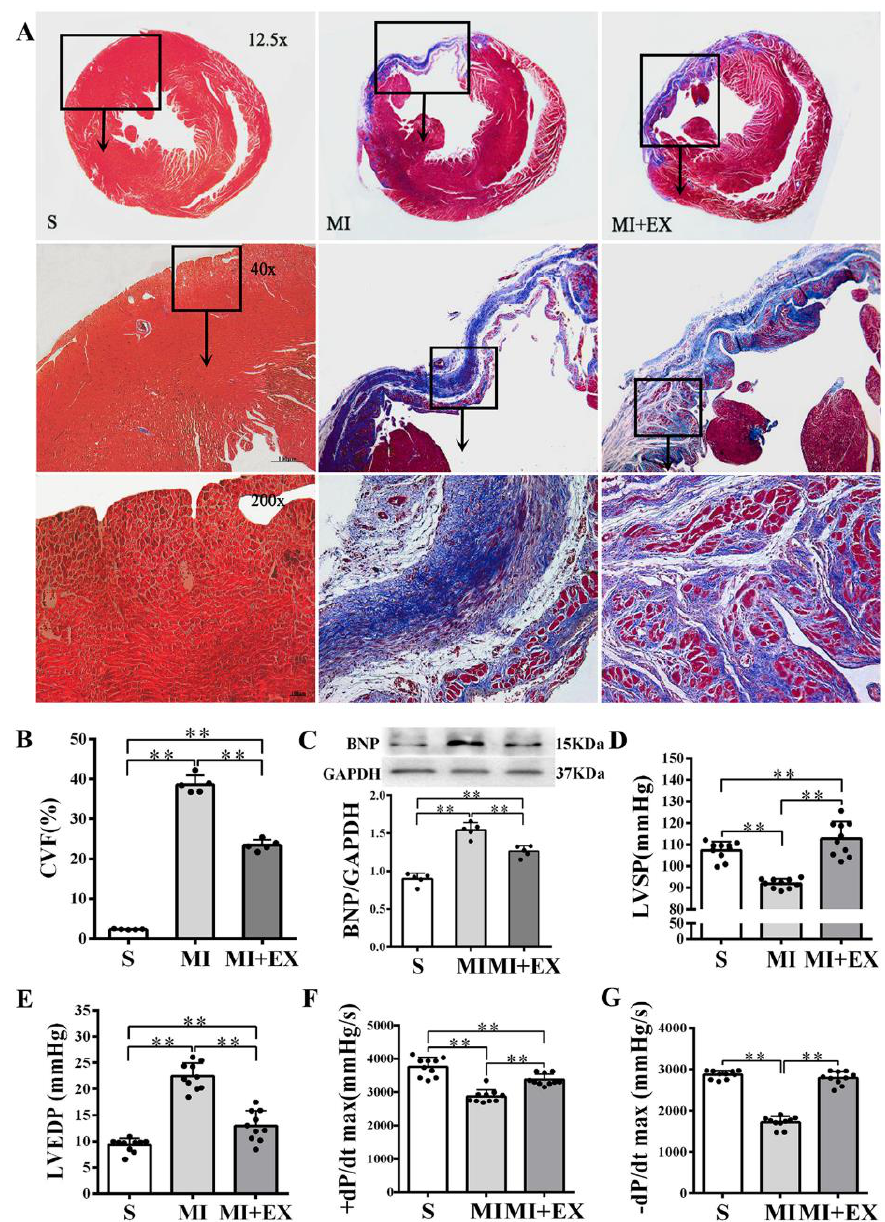
Figure 4. E ff ects of post-myocardial infarction (MI) exercise training on cardiac fibrosis and ventricular function: ( A ) Masson’s trichrome staining of cardiac tissue section for fibrosis evaluation. Images of cardiac muscle fibers (red color), collagen fibers (blue color), and nuclei (dark brown color) indicate the levels of fibrosis (scale bar = 100 µ m); ( B ) quantitative analysis of collagen volume of fraction (CVF) in the post-MI rat hearts ( n = 5 / group); ( C ) Western blotting analysis of brain natriuretic peptide (BNP) expression in the infarcted myocardium ( n = 5 / group); and ( D – G ) e ff ects of post-MI exercise training on cardiac function parameters ( n = 10 / group). Data are expressed as mean ± Standard Deviation (SD). Symbols indicate ** p < 0.01. Abbreviations: LVSP, left ventricular systolic pressure; LVEDP, left ventricular end-diastolic pressure; and ± dP / dt max , maximal rate of rise or decline of left ventricular pressure. Abbreviations of groups: S, Sham group; MI, MI alone group; and MI + EX, post-MI exercise training